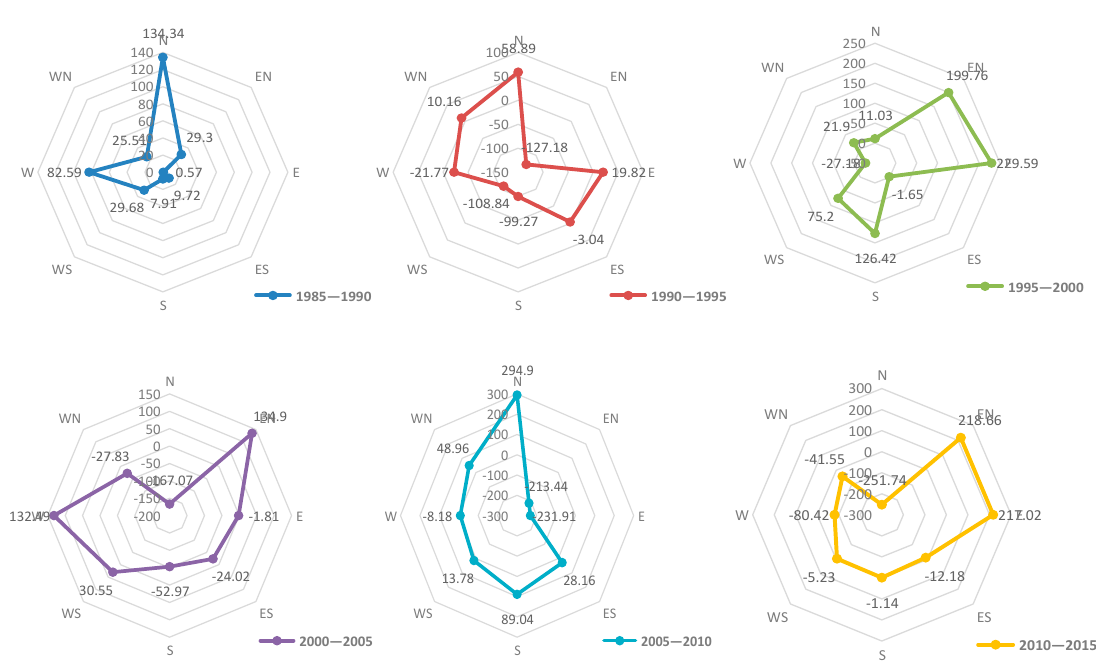
Figure 5. Spatial shrinkage differentiation of lakes in the study area from 1985 to 2015.